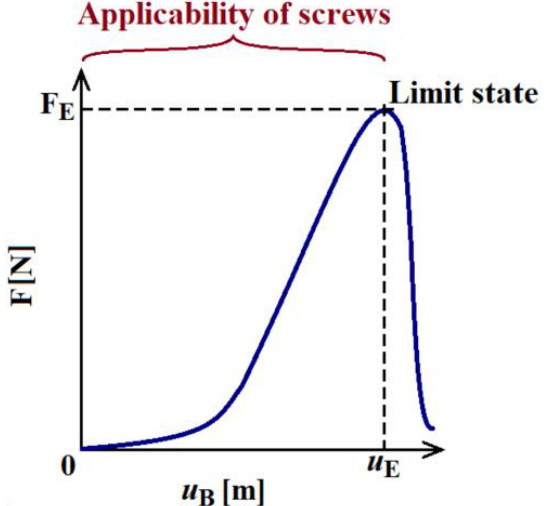
Figure 6. Pull-out test: A typical dependence of tensile force F on the screw elongation u B (determi- nation of extreme values of the pull-out test for screws in the